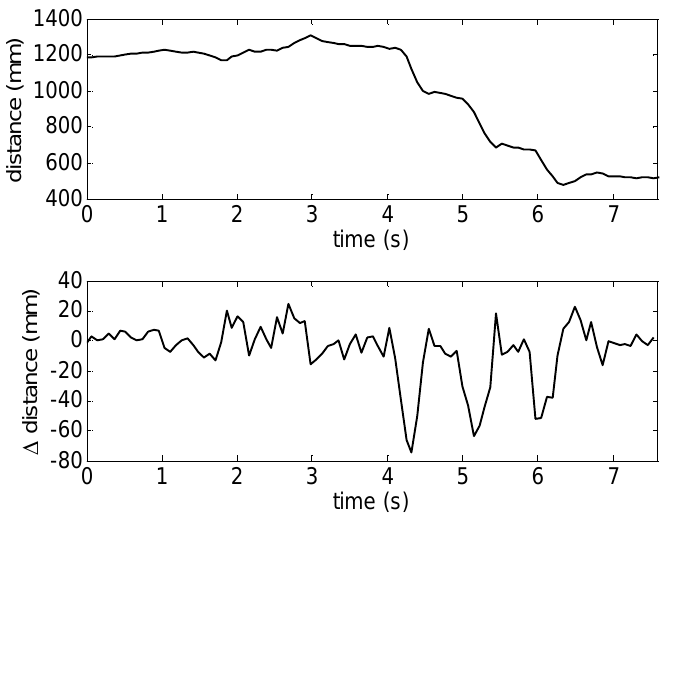
Figure 17. Distance to the frontal line obtained in one up stairs experiment (Figure